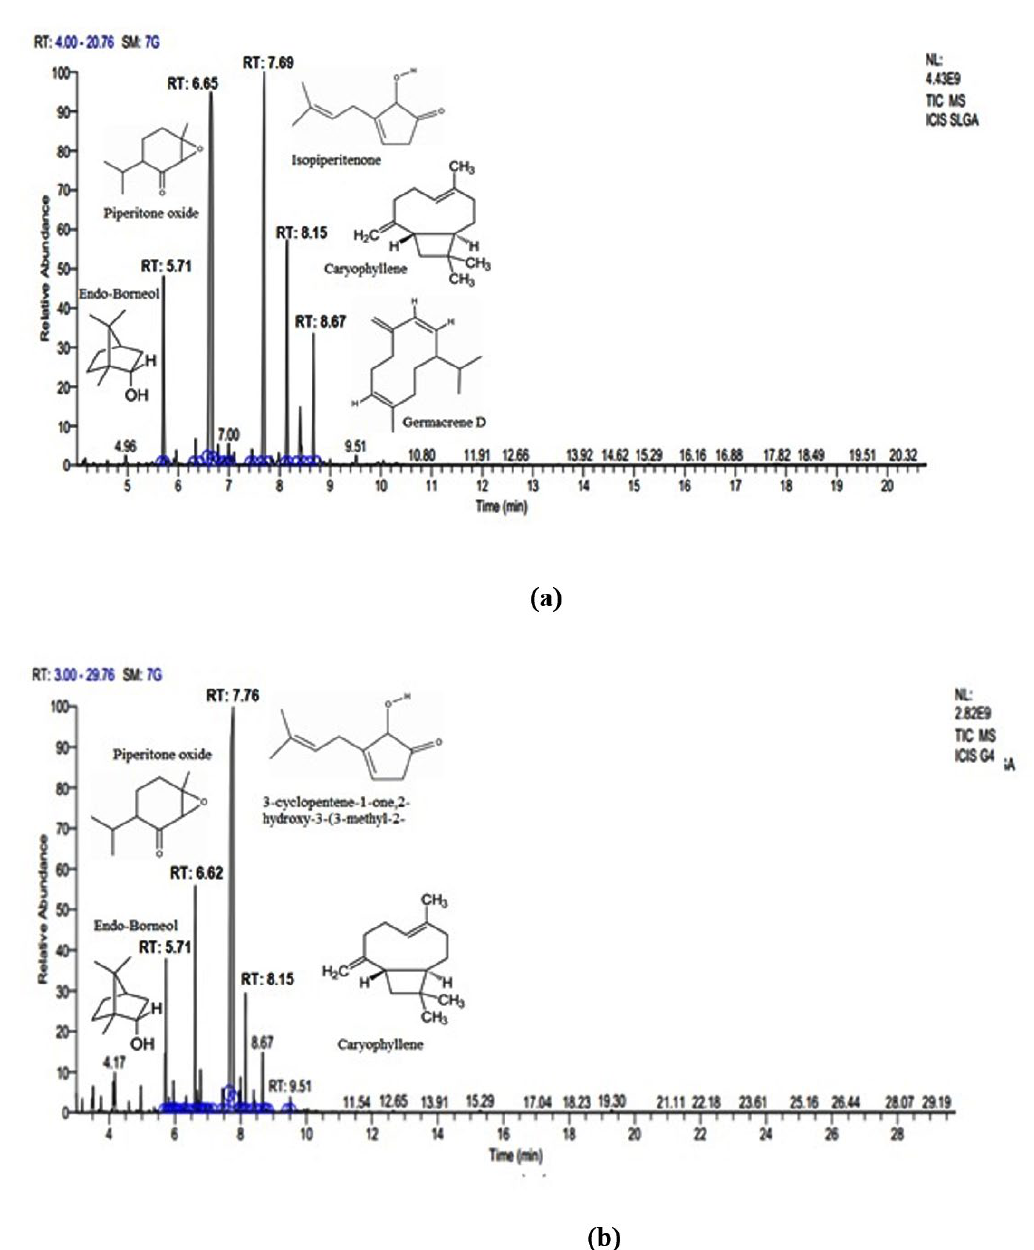
Fig. 2. GC-MS chromatograms of essential oil of M. longifolia obtained from leaves in the month of April (a) and July